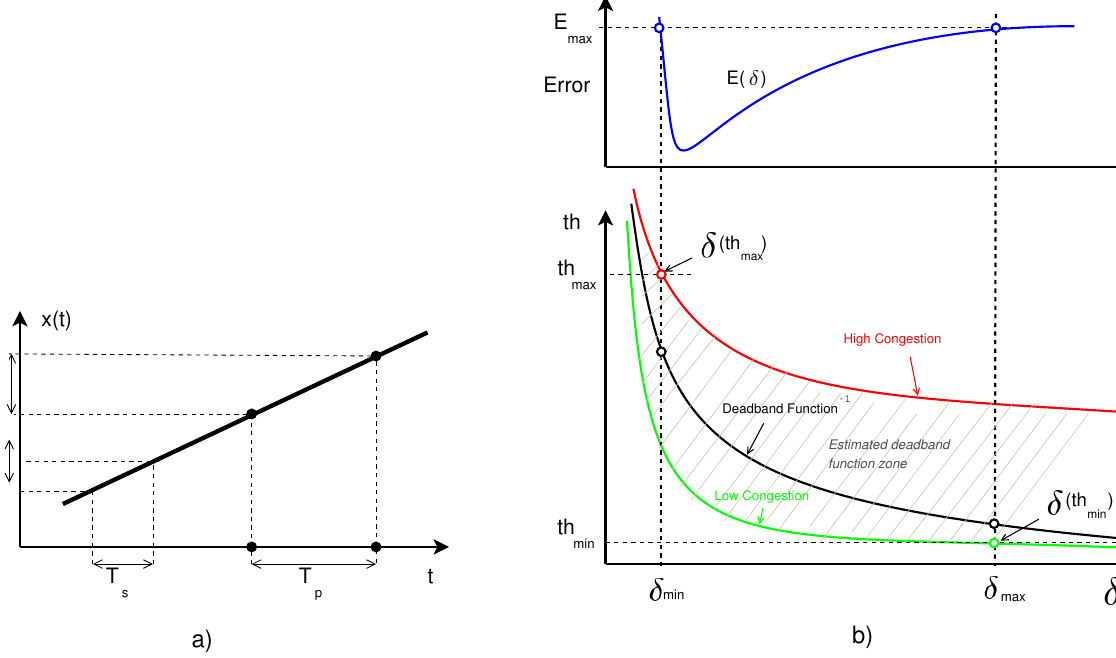
Figure 5. ( a ) Linear approach of th ( δ ) ; ( b ) Throughput and error versus